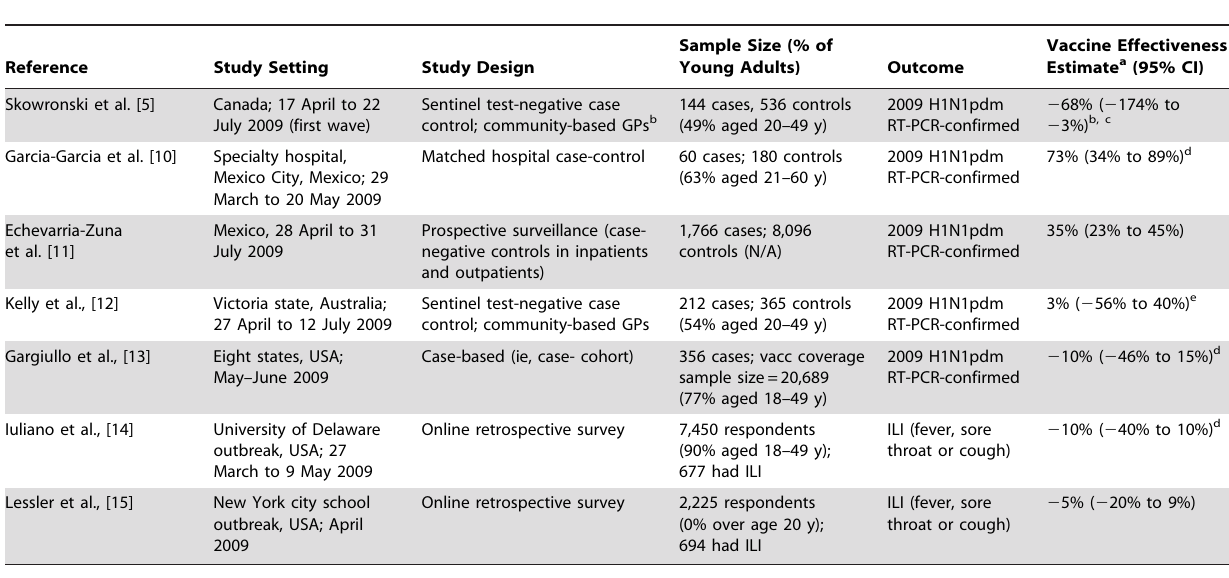
Table 1. Comparison of observational studies evaluating the effectiveness of seasonal influenza vaccination to prevent 2009 pA/ H1N1 morbidity in civilian